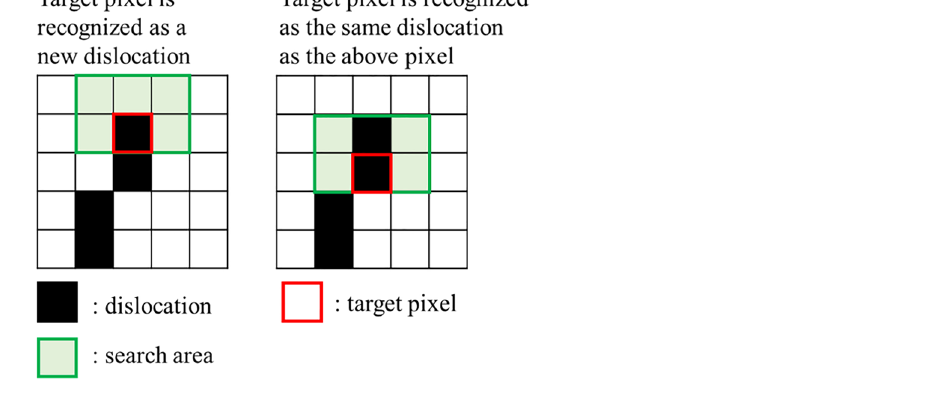
Figure 7. Method to identify each dislocation. This pre-process toward the particle filter determines that consecutive pixels are the same